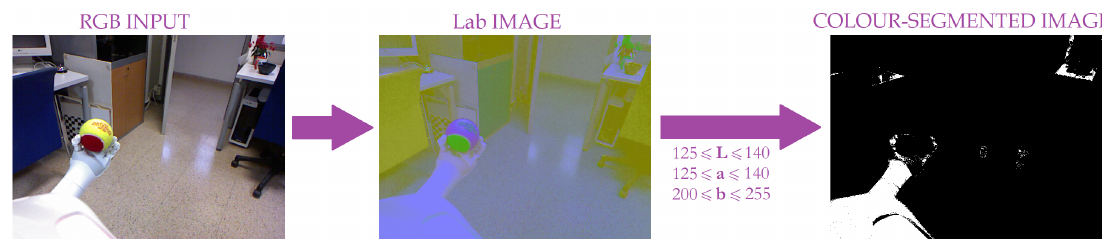
Figure 5. Image segmentation based on Lab colour